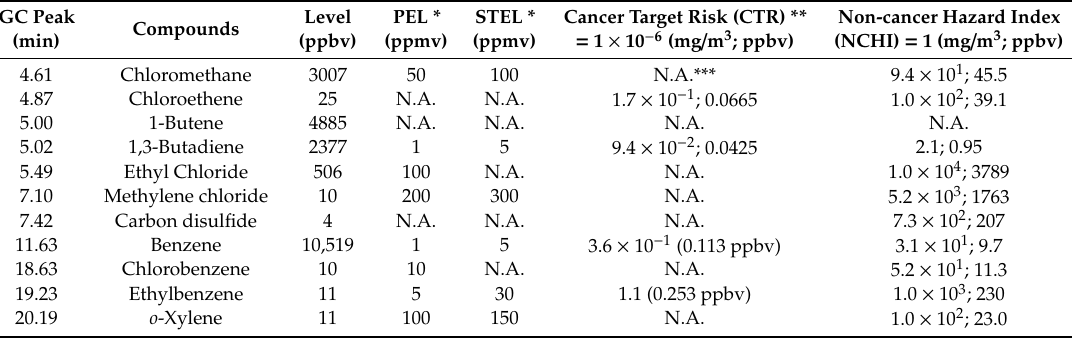
Table 2. Concentrations of major air pollutants in the emissions of burning PVC pipes and their comparison to Occupational Safety and Health Administration (OSHA) regulatory standards for permissible exposure levels (PEL) and USEPA health screening levels based on excess cancer risk = 1 × 10 − 6 and hazard index =